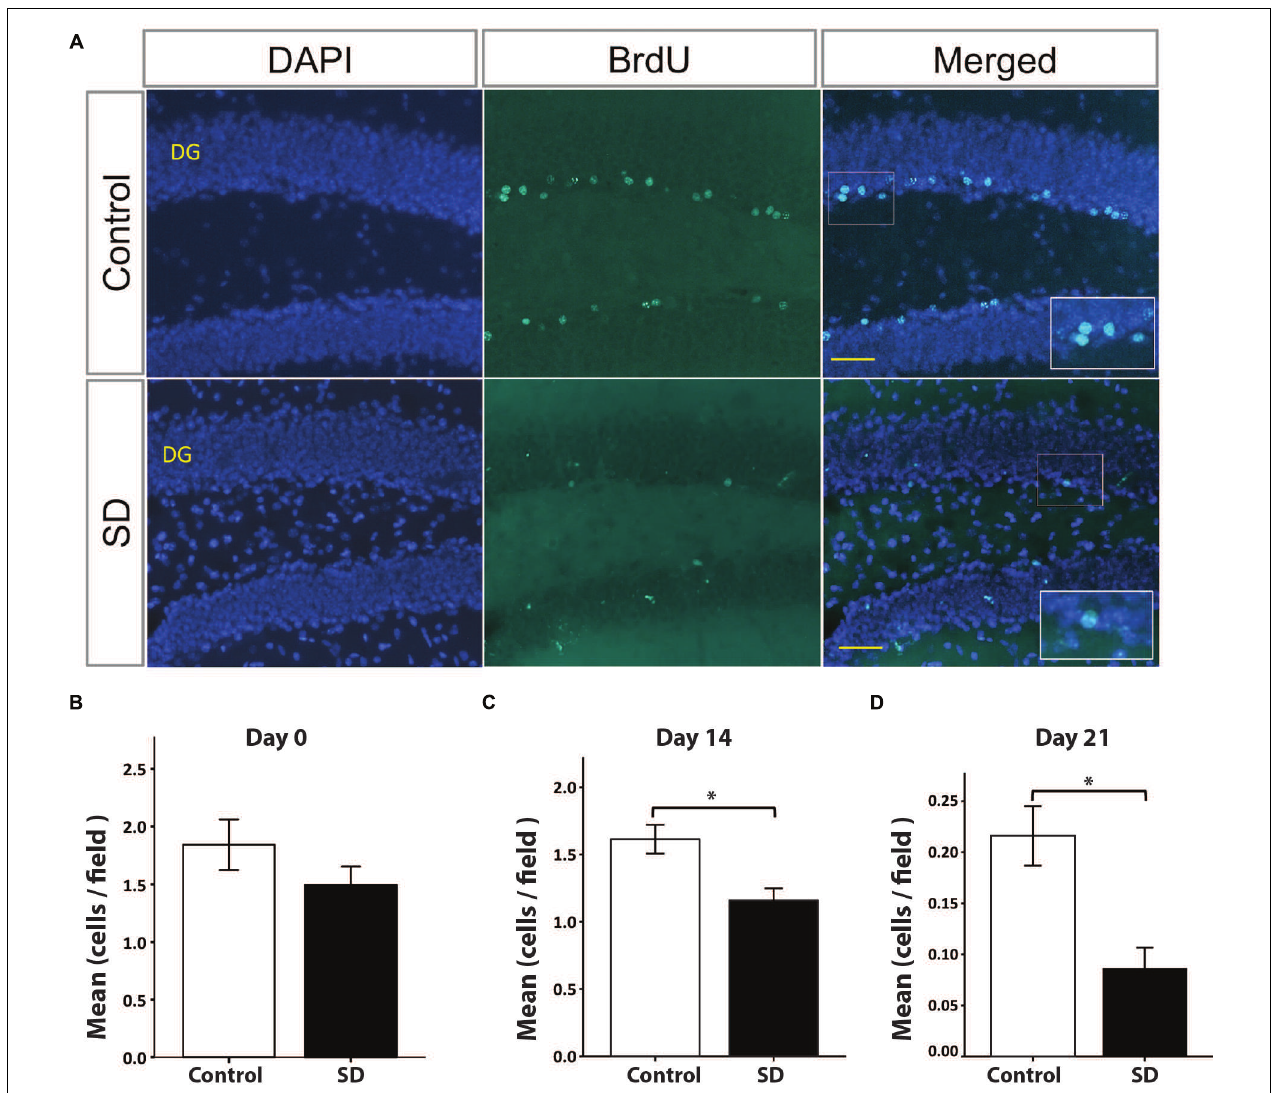
FIGURE 4 | BrdU + cells in the dentate gyrus decrease in REM SD groups. Representative pictures by immunofluorescence of the dentate gyrus (DG) of controls and the SD group (A) . The number of BrdU + cells in DG (green) was significantly reduced by the effect of SD at different time points: day 0 (B) , day 14 (C) , and day 21 (D) . Bars indicate the mean of BrdU + cells per field (445 µ m 2 ) ± SE. Asterisks Indicate statistical differences (Mann–Whitney “ U ” test). Nuclei are in blue by DAPI staining. Scale bar = 10 µ